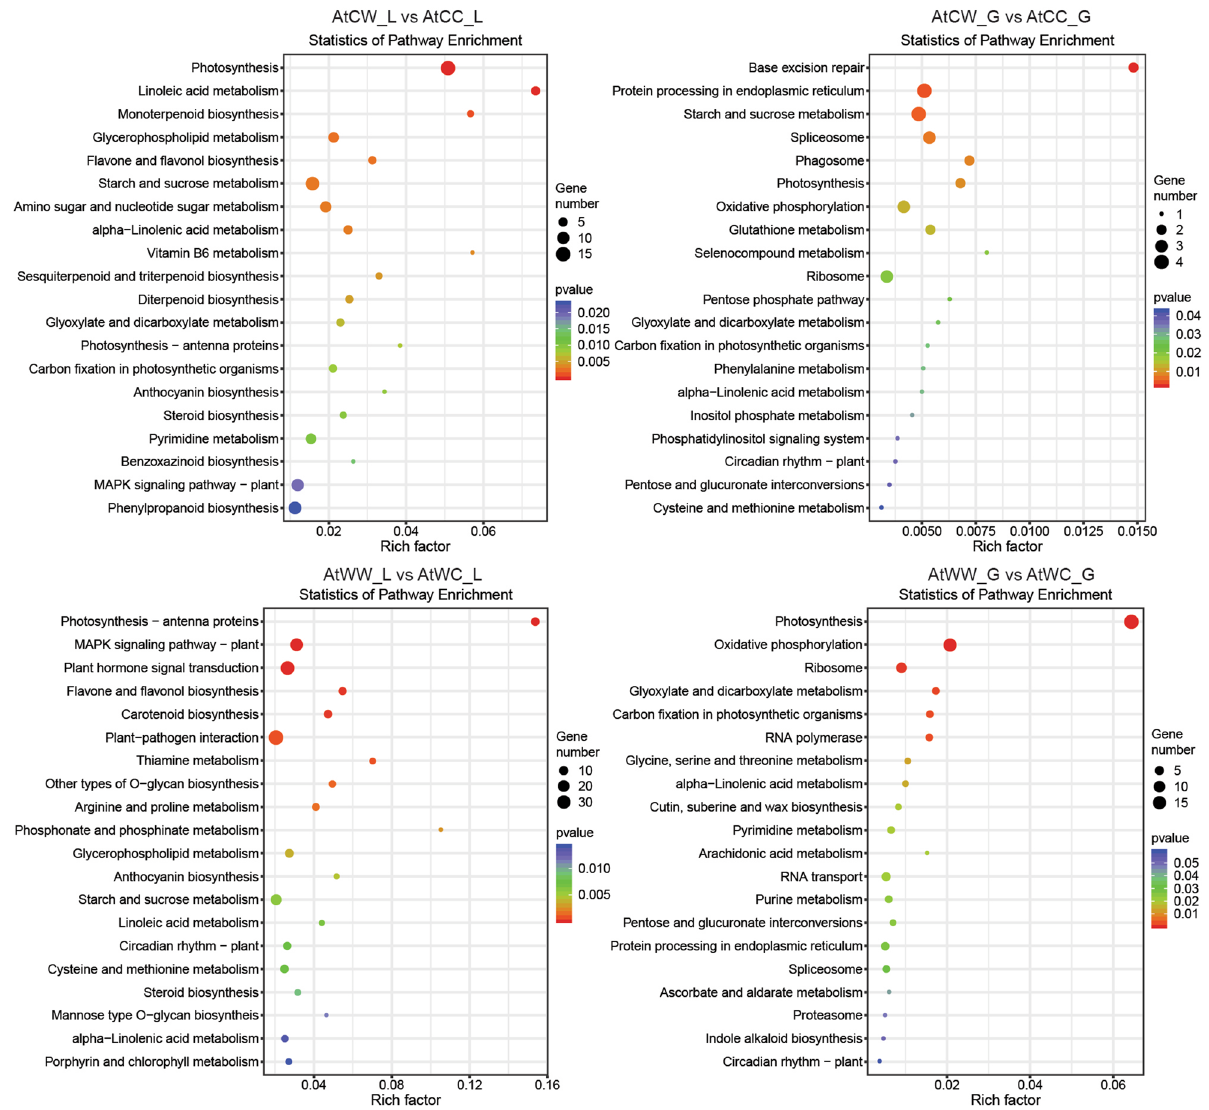
Figure 2. KEGG pathway enrichment analysis of stress-responsive genes in the progeny from the control parents and water-deficit stressed parents. The treatment groups are: AtCC (DBA Artemis control group parents, progeny treated with control), AtCW (DBA Artemis control group parents, progeny treated with water- deficit stress), AtWC (DBA Artemis water-deficit stress group parents, progeny treated with control), AtWW (DBA Artemis water-deficit stress group parents, progeny treated with water-deficit stress). _L represents flag leaf libraries, _G represents developing grain libraries. The rich factor represents the degree of enrichment, calculated based on the proportion of stress-responsive genes within all the genes under a specific KEGG